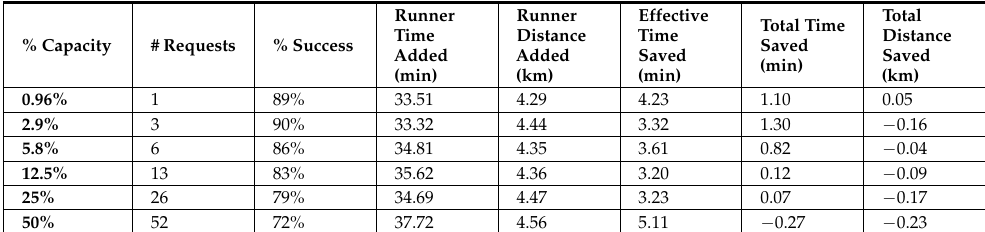
Table 4. Results from UCI campus feasibility study after restricting pickup requests to be greater than 1.5 km away and automatically dropping any request that can only be serviced by a runner who is more than 4 km away.